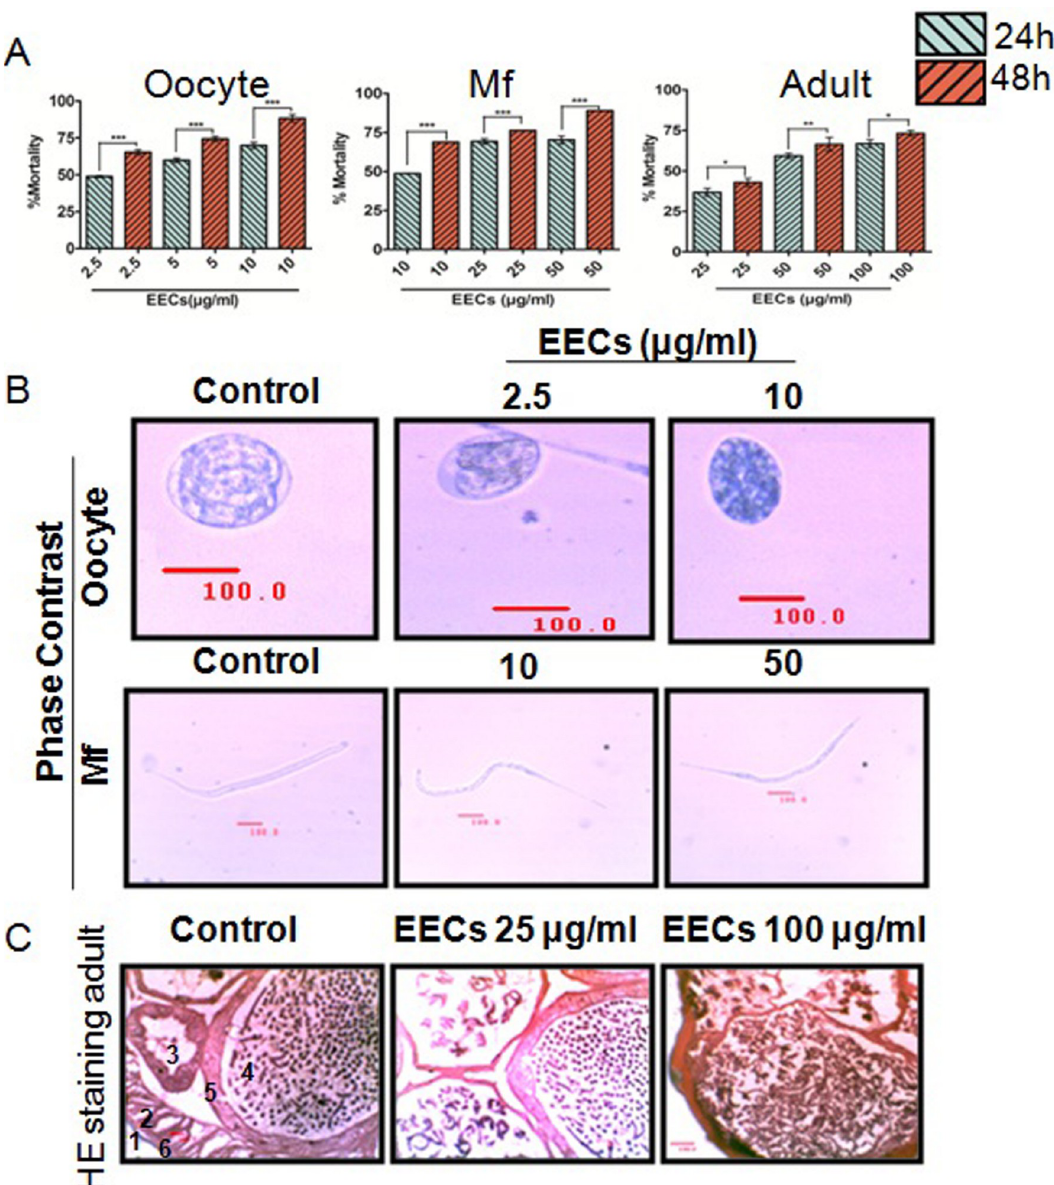
Fig 2. Antifilarial activity of EECs on the oocytes, microfilariae (Mf) and adults of the filarial parasite Setaria cervi . ( A.) Dose- dependent mortality in the oocytes (left panel), Mf (middle panel) and adult stage (right panel) of S . cervi treated with variable doses of EECs. (B.) phase contrast micrograph showing morphological changes in the EECs treated oocytes (upper panel) and Mf (lower panel). (C.) Histological changes in the adult of S . cervi after EECs treatment. Control section (i) showed no significant morphological damages in (1) cuticle, (2) longitudinal muscle layer, (3) intestine, (4) uterus, (5) uterine wall, and (6) hypodermis whereas, in (ii) and (iii) shrinkage and morphological alterations in the 25 μ g/ml and 100 μ g/ml of EECs treated parasites were visible at 20X magnification. Scale bar (100 μ m) was given using Dewinter Biowizard 4.2 software. Each data is the representative of five independent experiments repeated for at least three times. Data in the bar graph represents mean ± SEM and p < 0.001 considered as statistically